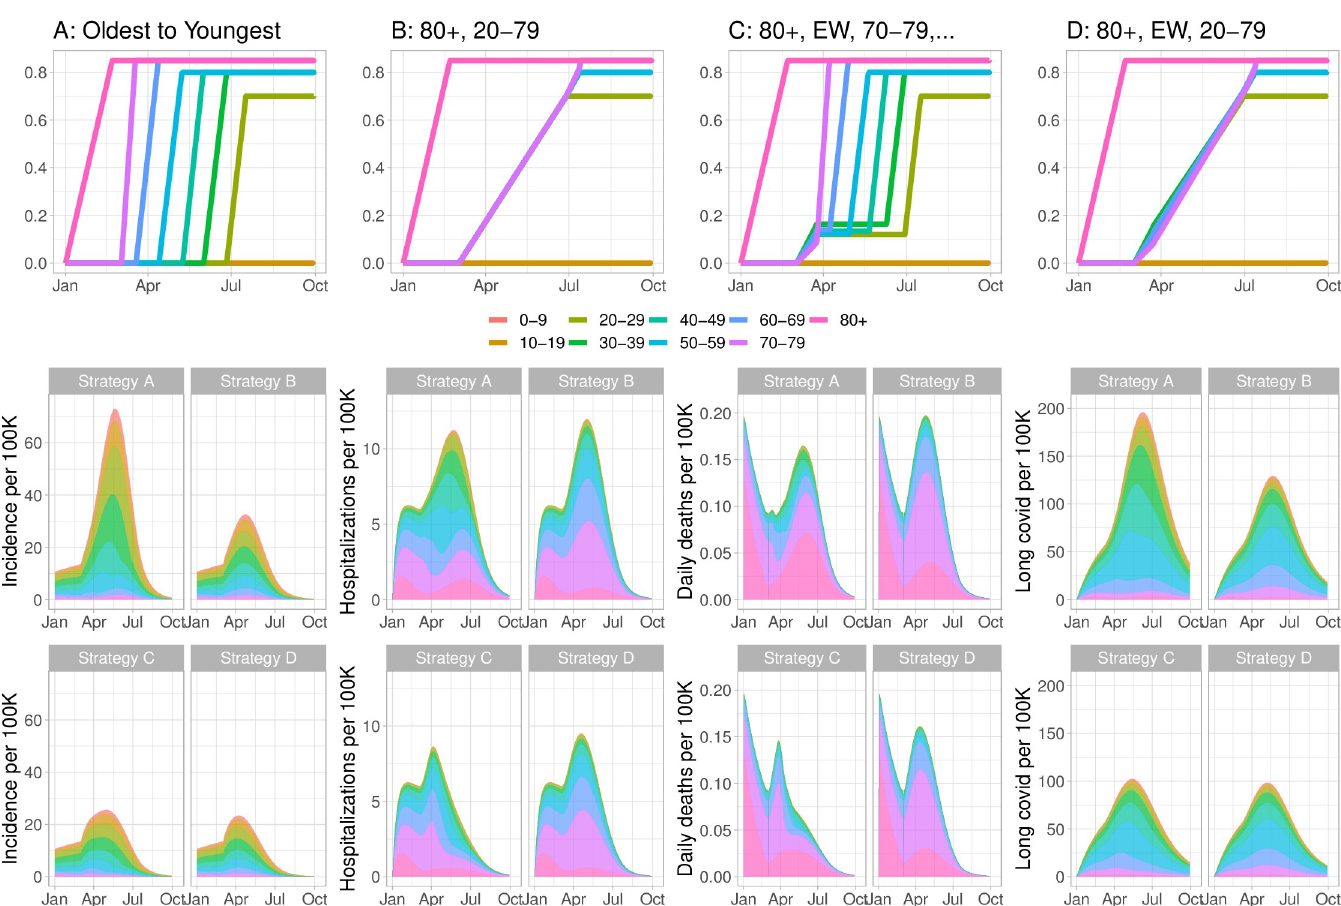
Fig 1. Vaccinating younger adults sooner, and vaccinating essential workers sooner, reduces cases, deaths, hospitalizations and Long COVID (COVID symptoms lasting longer than 28 days). In our model the rollout consists of an initial phase during which those over 80 are vaccinated and R = 1.05, followed by a second stage where the transmission rate is higher ( R = 1.3 here). In these simulations vaccine efficiency is 90% for preventing disease and 75% at preventing infection and therefore subsequent transmission. Top row: Illustration of the vaccination programs by age group over time: Fraction of the age group vaccinated versus time. Next two rows: Simulated cases, hospitalization, deaths and Long COVID prevalence over